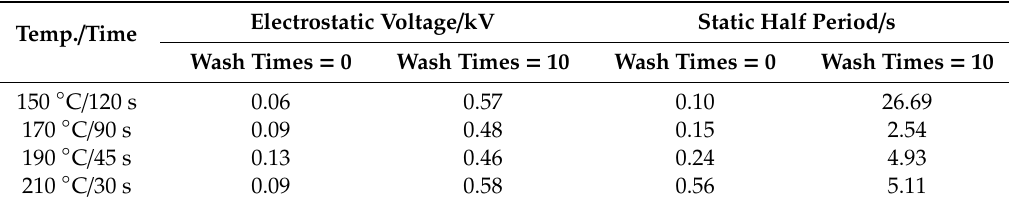
Table 2. Effect of curing temperature and time on electrostatic voltage and static half period against repeated washings.